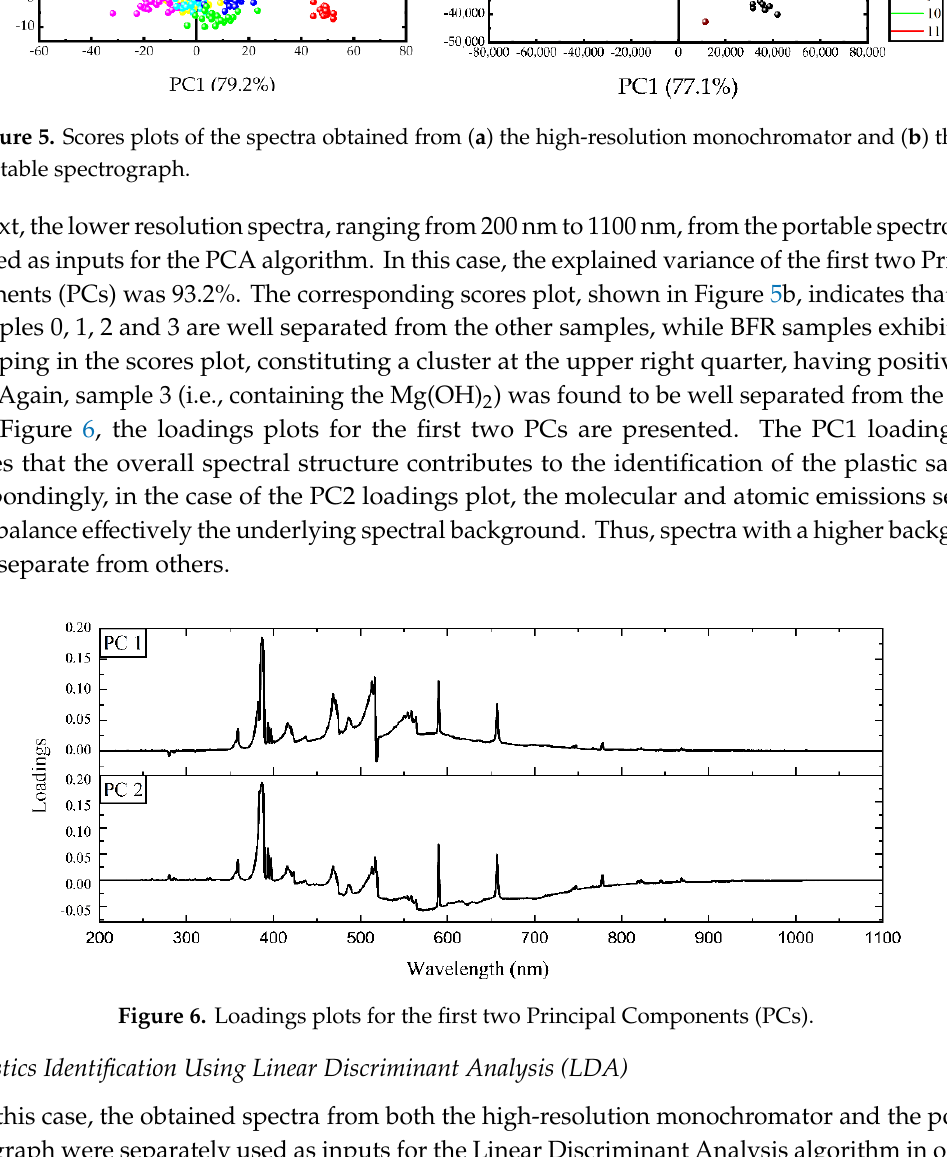
Figure 5. Scores plots of the spectra obtained from ( a ) the high-resolution monochromator and ( b ) the portable spectrograph.